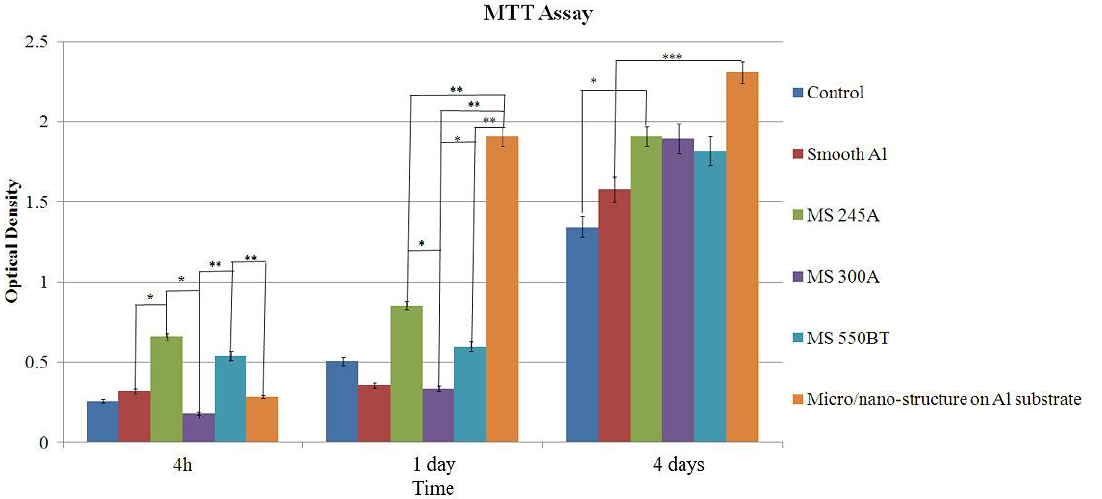
Figure 4. The microculture tetrazolium test (MTT) assay for different structured templates. (Values are the mean ± SD of six experiments ( n = 6), * p < 0.05, ** p < 0.01, *** p < 0.001).